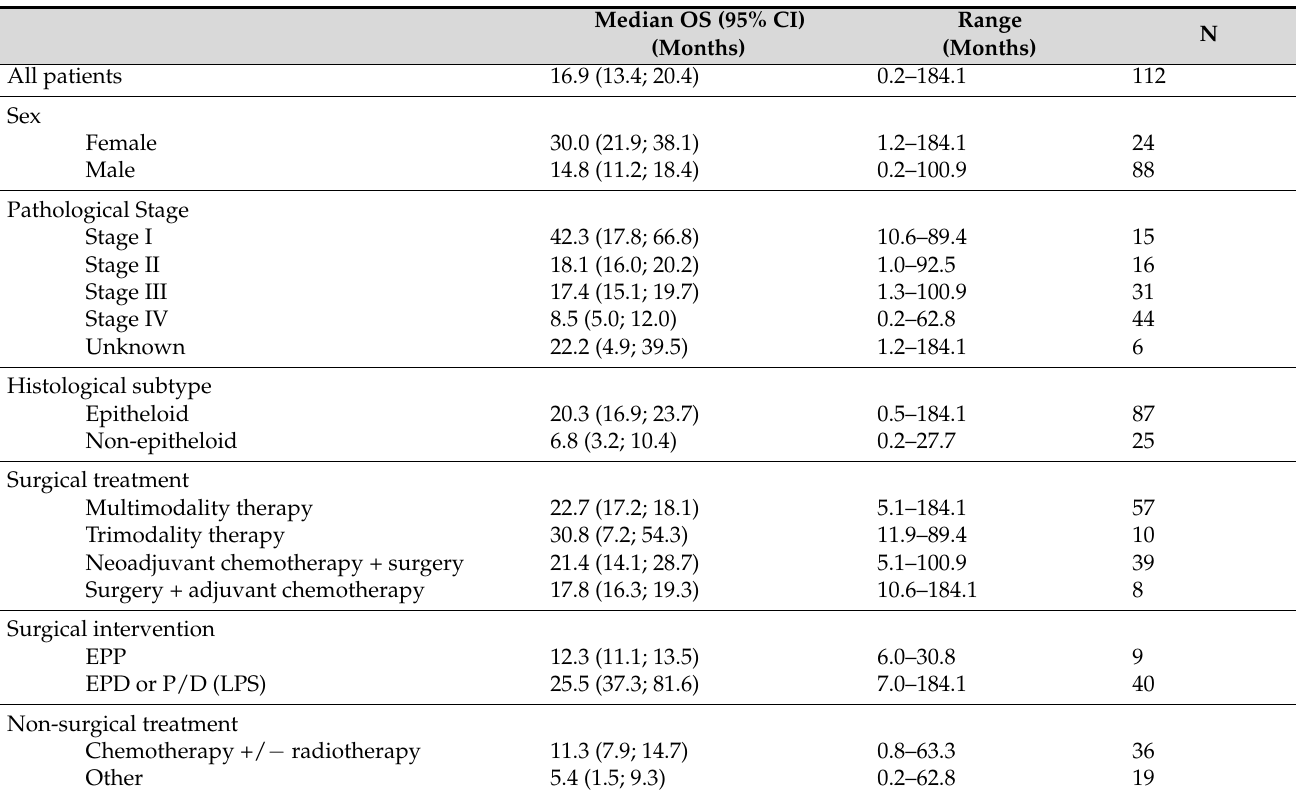
Table 4. Survival rates in months for different subgroups and interventions. In total, 112 patients were analyzed. EPD extended pleurectomy/decortication, EPP extrapleural pneumonectomy, LPS lung-preserving